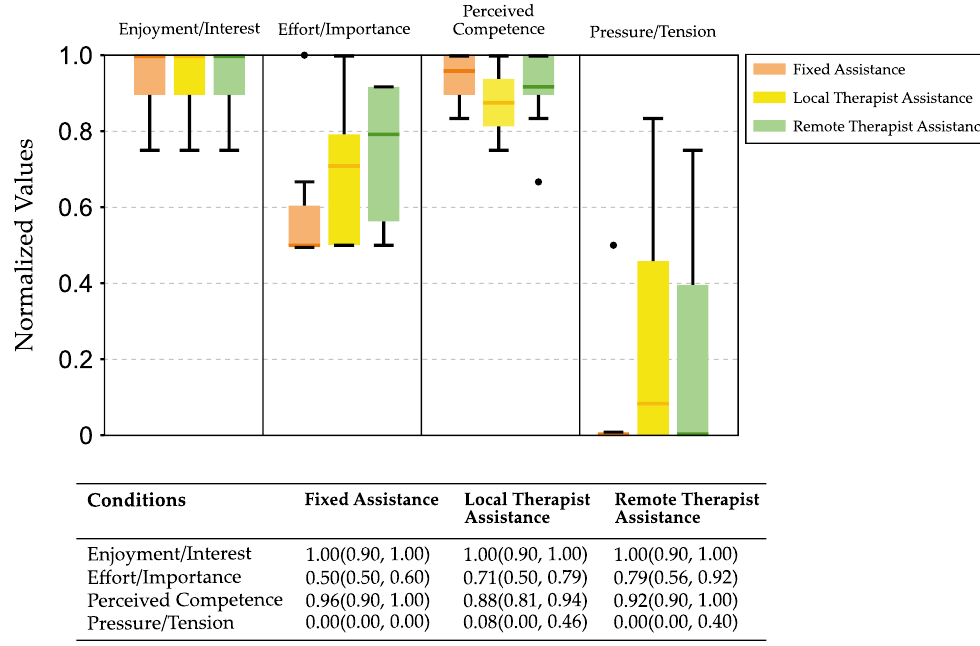
Figure 11. Results from the Intrinsic Motivation Inventory for all three conditions of the study. The table collects the median value and the first and third quartiles of each parameter from the Intrinsic Motivation